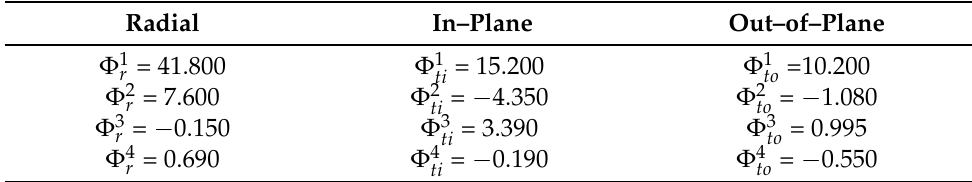
Table 4. Force constants for graphene in units of 10 N/m.